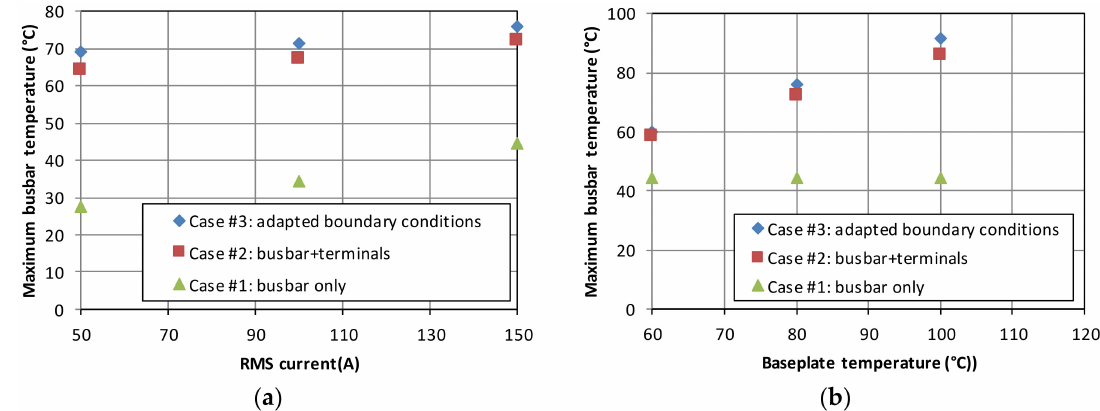
Figure 11. Comparison of different calculation methods to estimate the maximum busbar temperature (Module K): ( a )Effect of the Root Mean Square (RMS) current— T bp = 80 ◦ C; ( b ) Effect of the baseplate temperature— I eff = 150